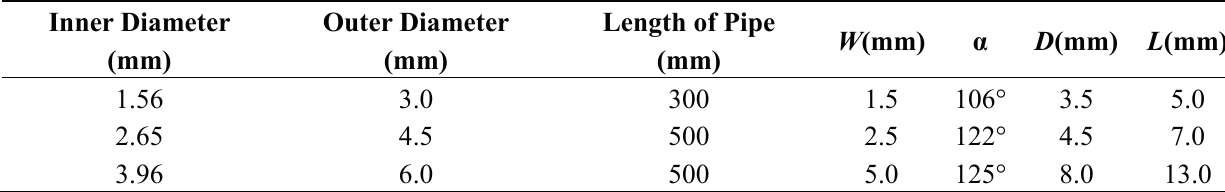
Table 1. Structure parameters of the capacitance